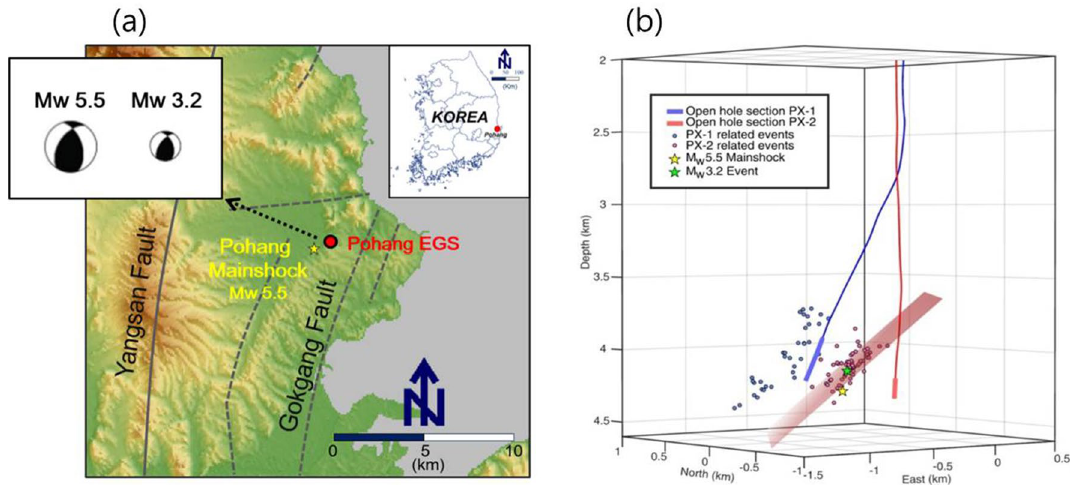
Figure 1. ( a ) Location map of the Pohang Enhanced Geothermal System (EGS) site, South Korea. Map was generated using Generic Mapping Tools (GMT) software, version 4.5.9 47 (http:// gmt. soest. hawaii. edu/ proje cts/ gmt). ( b ) a perspective view of the earthquakes related with the events at PX-1 and